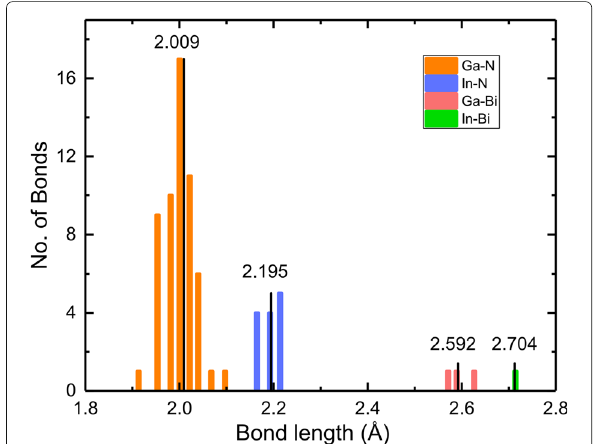
Fig. 2 Histogram of bond length in In 0.25 GaNBi 0.0625 . The values in panel indicate the average lengths of the four types of bond